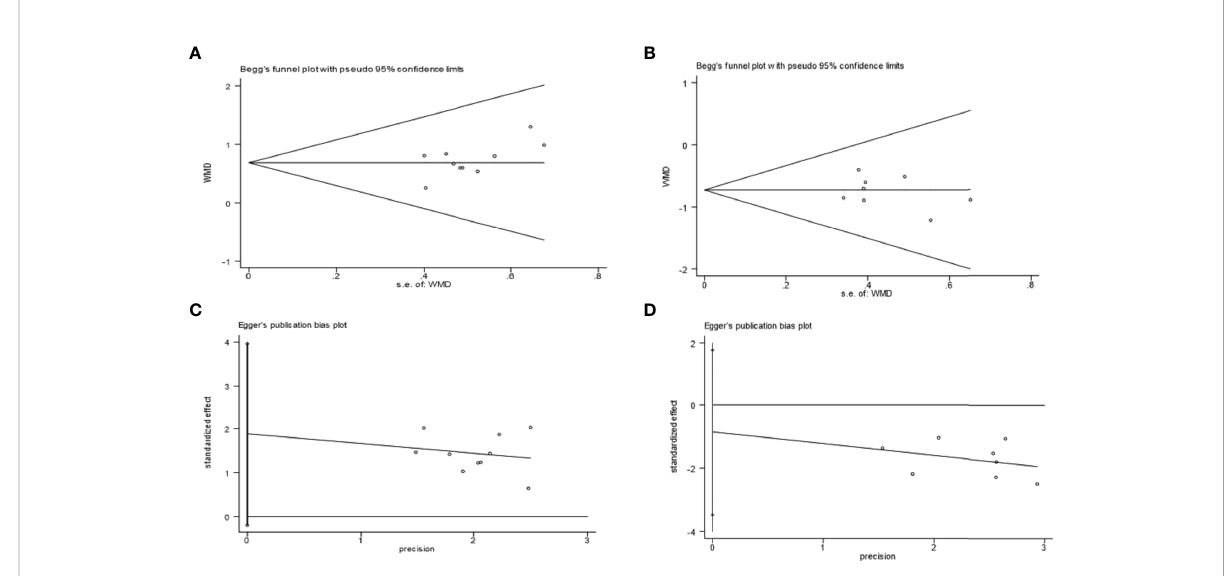
FIGURE 8 Examples of Begg ’ s funnel plots: Bi fi dobacterium (A) and Enterobacteriaceae (B) ; examples of Egger ’ s publication bias plots: Bi fi dobacterium (C) and Enterobacteriaceae (D) .